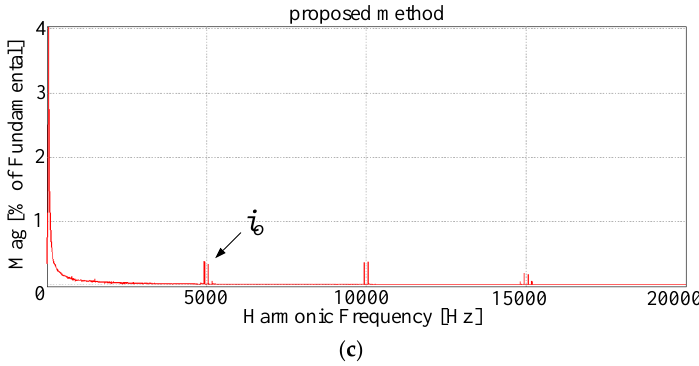
Figure 8. FFT analysis of output current ( i o ) with average switching period ( f avg = 5 kHz): ( a ) conv-MPC ( T s = 33 μs); ( b ) PI-PWM method ( T sw = 200 μs); ( c ) proposed method ( T s = 200 μs).